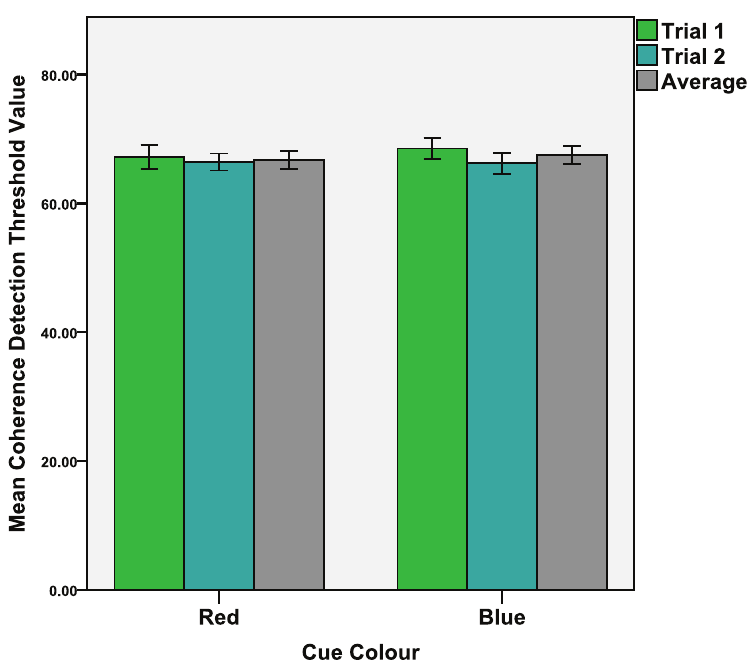
Figure 3. Mean detection threshold values for the coherence (global) task. Mean values of the 1st and 2nd trials as well as the average value of both trials. Error bars indicate the 95% confidence interval .